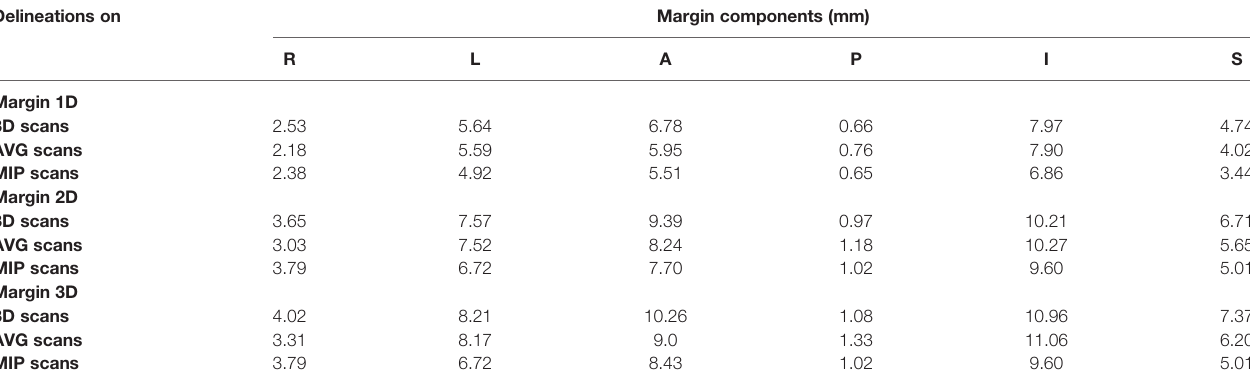
TABLE 4 | Overall mean error M and systematic error S used to derive margins for delineations on the AVG and MIP scan using the full extent of motions as ground truth. Delineations on Margin components